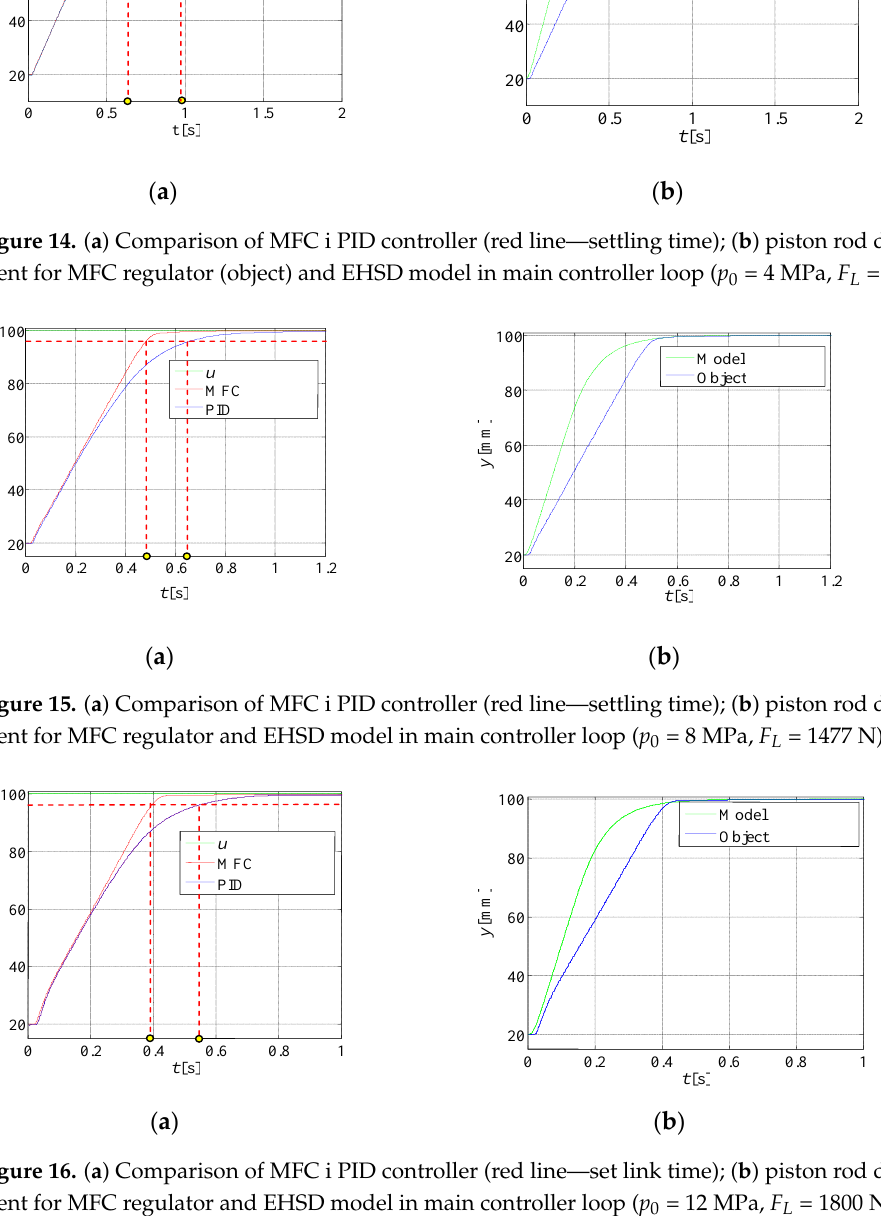
Table 1. Settling time comparison.